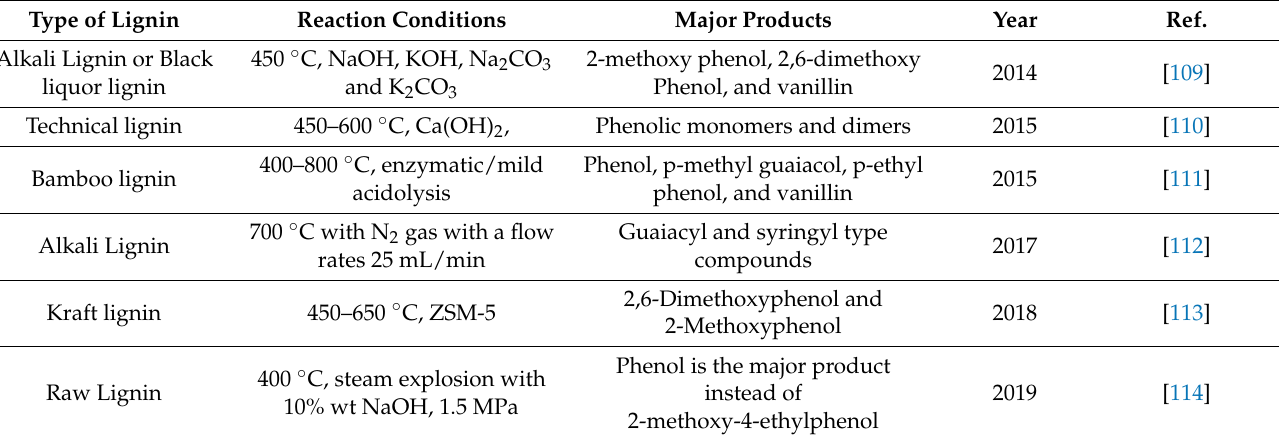
Table 5. Depolymerization of lignin by